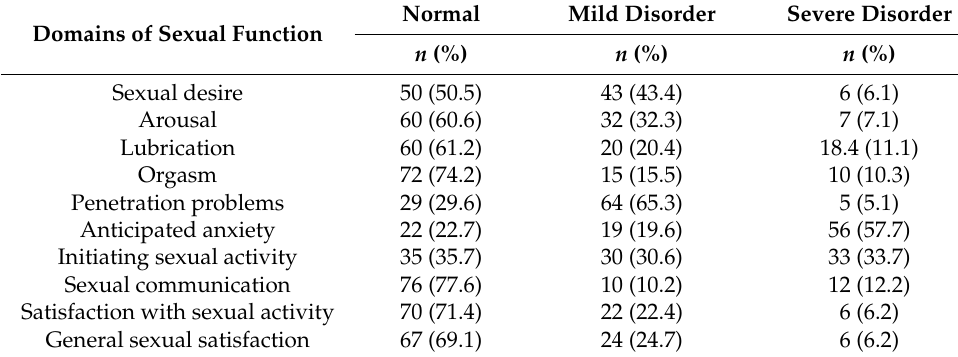
Table 2. Disorders in domains of sexual function in the postpartum period.